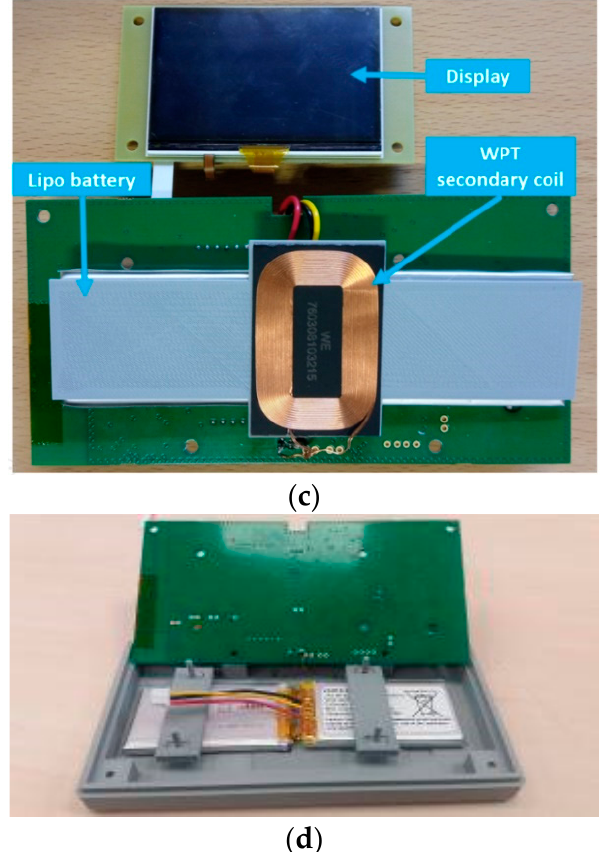
Figure 15. USER-ED prototype: ( a ) view of the encased prototype; ( b ) top view of the electronic board; ( c ) bottom view of the electronic board; ( d ) batteries and encapsulation.